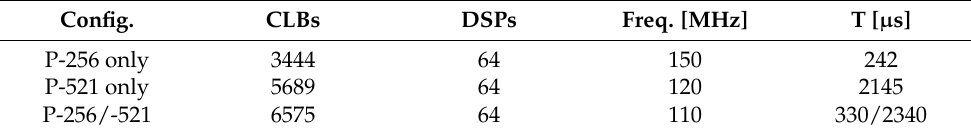
Table 5. ECC Crypto-Core Resources Utilization on Zynq UltraScale+ xczu7ev-vc1156-2-e MPSoC. Config.